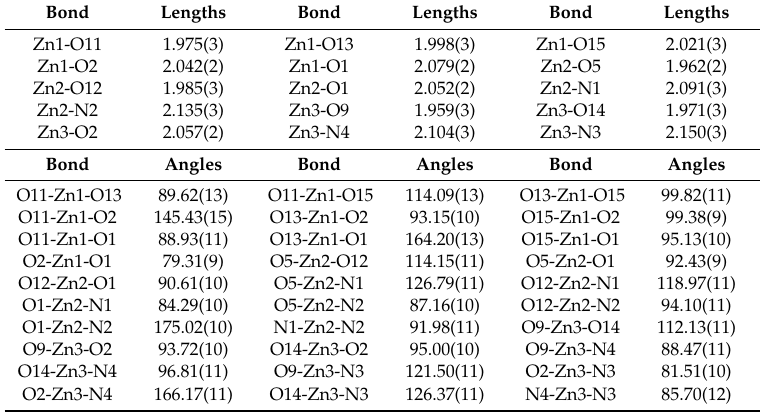
Table 2. Selected bond lengths (Å) and angles ( ◦ ) for the Zn II coordination compound. Bond Lengths Bond Lengths Bond Lengths